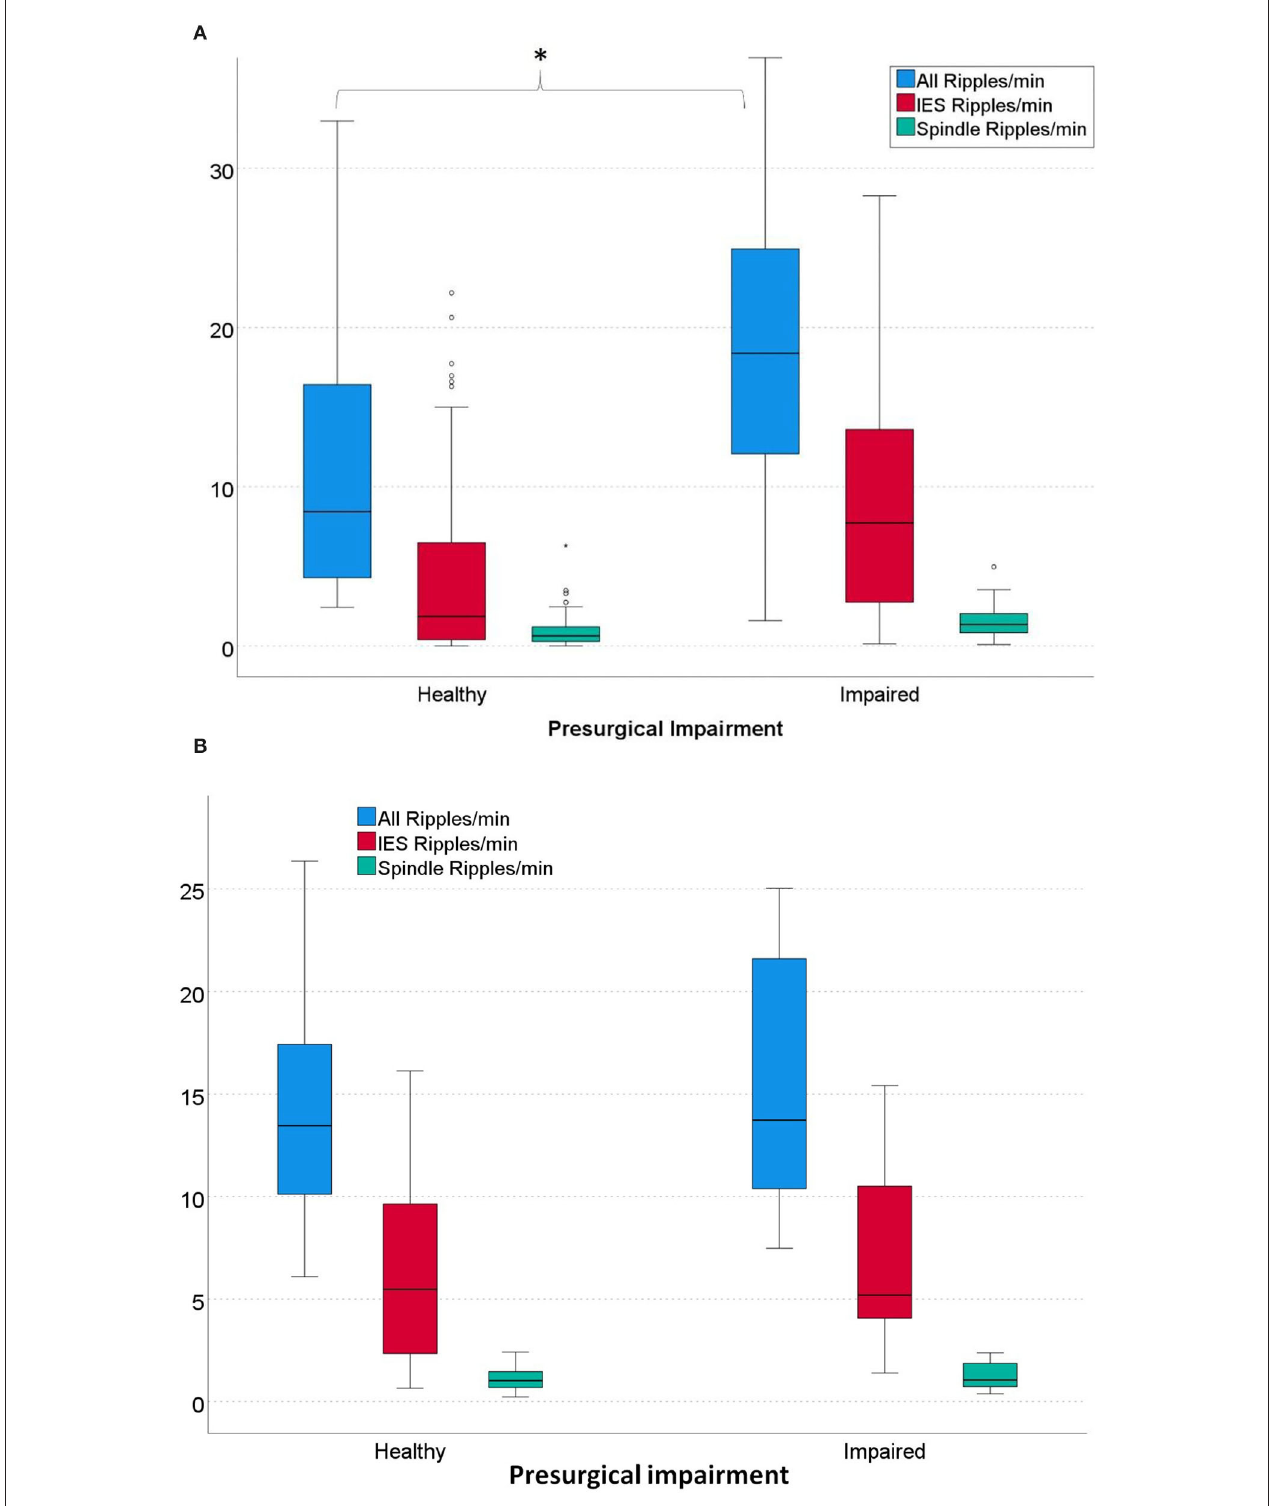
FIGURE 3 | (A) Rates of left-sided mesial-temporal ripples in patients with healthy vs. impaired pre-surgical verbal memory. Patients with impaired verbal memory had significantly higher overall ripple rates than patients with healthy memory. (All Ripples: * p = 0.039; IES Ripples: p = 0.078; Spindle ripples: p = 0.379). α = 0.05. (B) Rates of all right-sided mesial-temporal overall Ripples and IES Ripples in patients with healthy vs. impaired pre-surgical non-verbal memory. No significant differences were seen for all three ripple types (All Ripples: p = 0.606; IES Ripples: p = 0.541; Spindle Ripples: p = 0.423); α = 0.05.